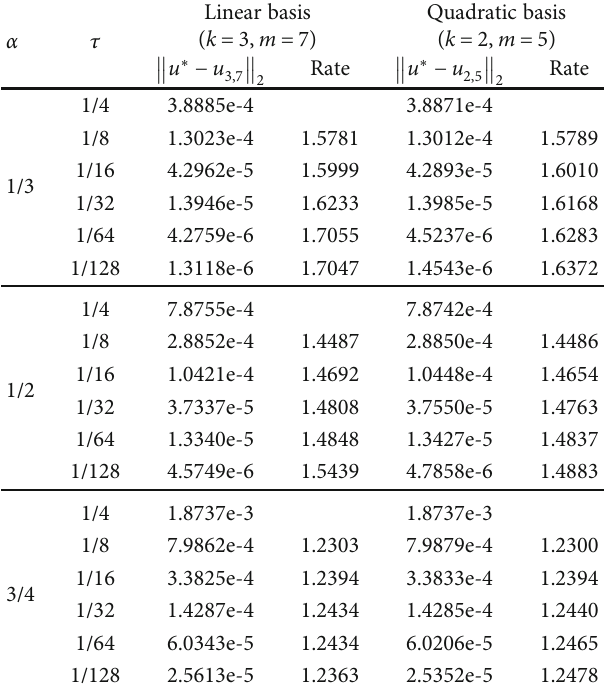
direction for Example